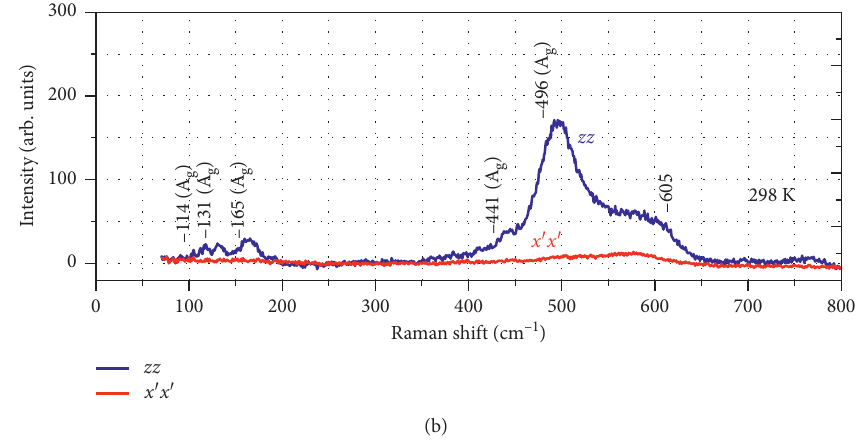
Figure 3: zz and x ′ x ′ polarization Raman spectra of (110)-oriented Al doped PBCO thin films.